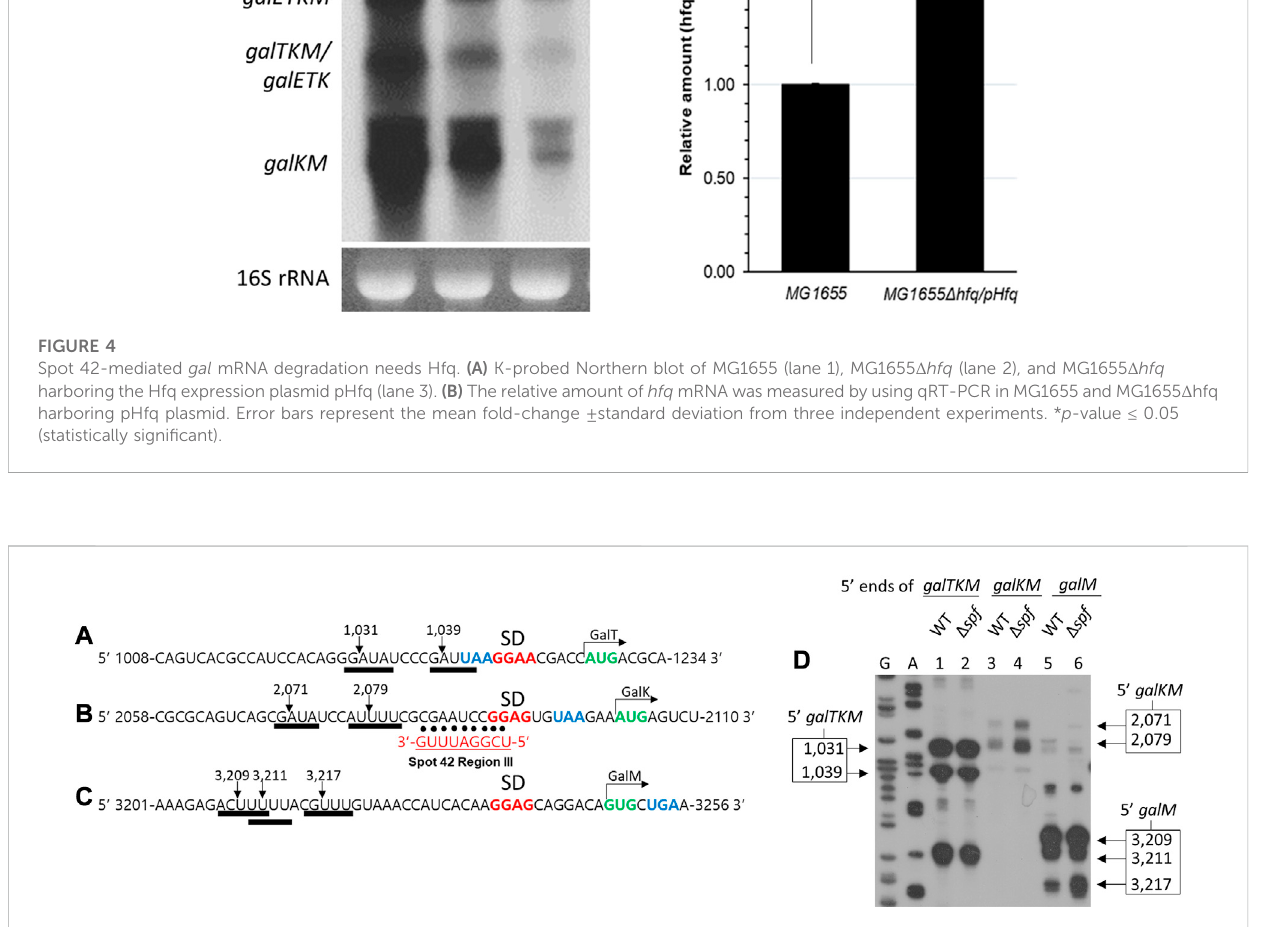
FIGURE 5 Spot42negativelyregulatesRNaseEcleavage thatgenerates galKM. Nucleotidesequencesupstreamofthetranslationinitiationcodonsof galT (A) , galK (B) , and galM (C) , show the correspondence of the cleavage positions (inverted arrows) of the RNase E consensus cleavage sites (thick underlines). AlsohighlightedaretheputativeShine – Dalgarnosequences(inbold red)andtheinitiation (green)andtermination(blue)codons.TheRNaseEcleavages in (A) , (B) , and (C) result in the generation of the 5 ′ end of galTKM , galKM, and galM , respectively. Base pairing of region III to the corresponding regions of gal are presented with dots. (D) 5 ′ RACE results show the 5 ′ ends of galTKM at 1,031 and 1,039 in wild type (WT) (lane 1) and Δ spf (lane 2), the 5 ′ endsof galKM at2,071and2,079inwildtype(WT)(lane3),and Δ spf (lane4),andthe5 ′ endsof galM at3,209,3,211,and3,217inwildtype(WT)(lane5)and Δ spf (lane